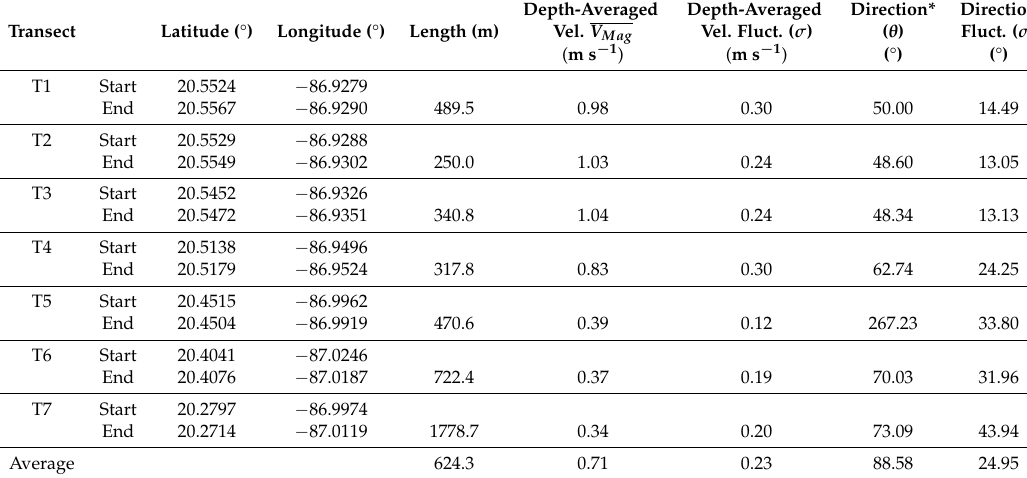
Table 1. Velocity magnitude, flow direction and coordinates of selected transects in the east-coast of Cozumel Channel.